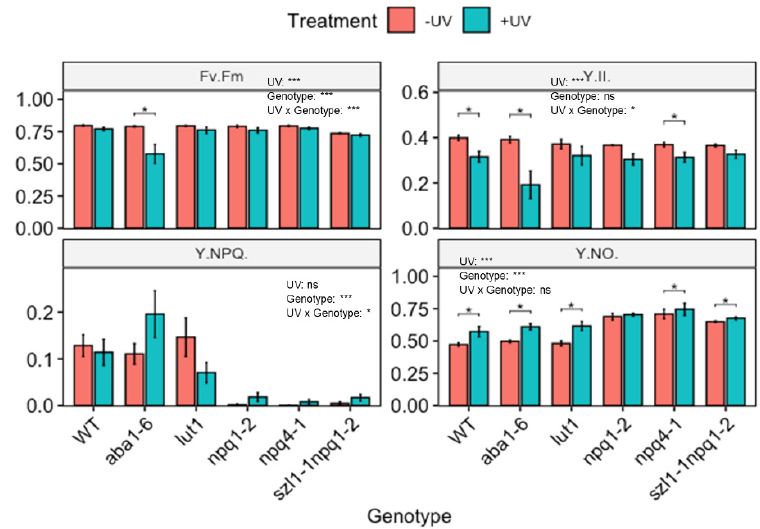
Figure 6. Photosynthetic efficiency of wild-type (WT) and carotenoid biosynthesis ( aba1-6 , lut1 , npq1-2 , npq4-1 and szl1-1npq1-2 ) impaired Arabidopsis thaliana (Col-0). Plants were subjected to UV treatment for 3.75 h daily and harvested after 18 h on day 4. F v /F m : the maximum quantum efficiency of photosystem II (PSII); Y(II): the quantum efficiency of PSII under steady-state light conditions; Y(NO): yield of non-regulated non-photochemical energy dissipation and Y(NPQ): the yield of regulated non-photochemical energy dissipation. Bar plots show means and error bars indicate standard error for n = 5. The text in each panel shows the outcome of a two-way ANOVA across treatment and exposure duration. The stars above pairs of bars show the outcome of t -tests between the UV treatments. In both cases * ( p < 0.05) and *** ( p < 0.001) depict significant differences with ns depicting a non-significant